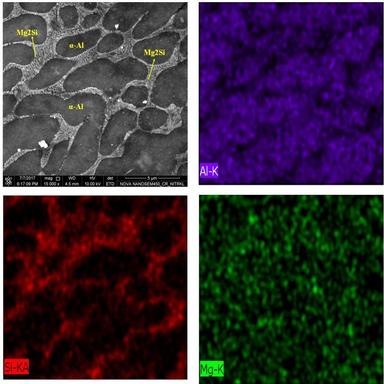
Elemental mapping of brazed zone (3 kW power).